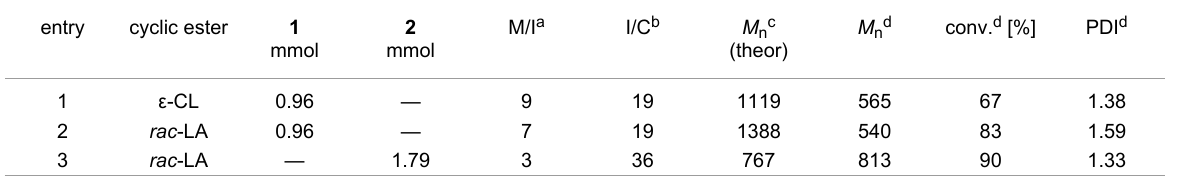
Table 3: ROP of ε -CL and rac -lactide in the presence of NaBPh 4 and benzyl alcohol ( 1 ), or ethylene glycol ( 2 ), at 75 °C for 75 min.